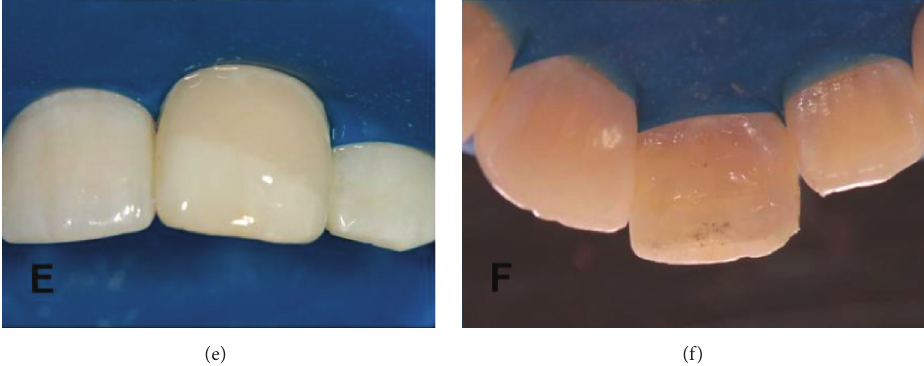
Figure 8: Cemented biopins in the remaining tooth. (a) Vestibular view. (b) Incisal view. (c) Clinical sample of the dental fragment. (d) Fragment adapted to the remaining tooth. (e) Vestibular aspect after bonding the vestibular fragment. (f) Palatal aspect after bonding the fragment.